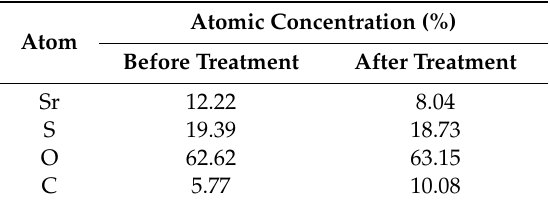
Figure 14. ( a ) Sr 3d, ( b ) S 2p, and ( c ) O 1s spectra on celestite surface treated with ferric ions and NaOL, (ferric ion: 5 × 10 − 5 mol/dm 3 , NaOL: 5 × 10 − 5 mol/dm 3 ) (The red lines are original curves and the green lines are background curves). Table 4. Atomic concentrations of celestite samples before and after NaOL Table 4. Atomic concentrations of celestite samples before and after NaOL treatment.